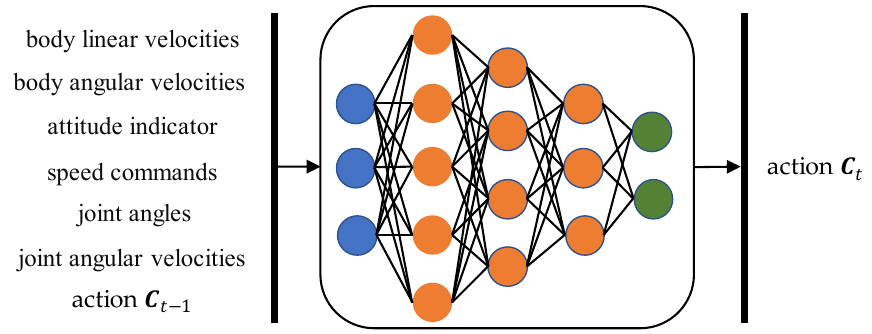
Figure 5. The structure of action policy neural network.